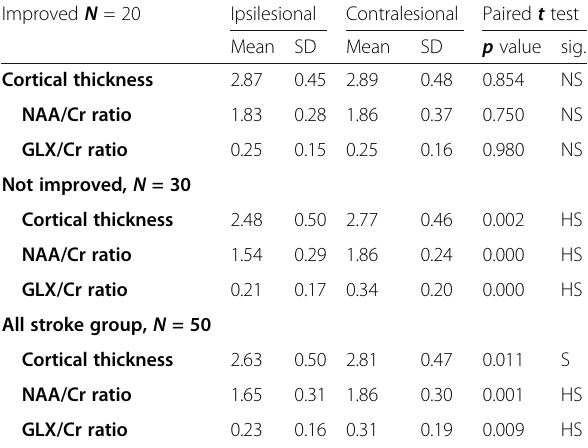
Table 1 Comparison between ipsilesional and contralesional cortical thickness and metabolite ratios in the improved, not improved, and all stroke